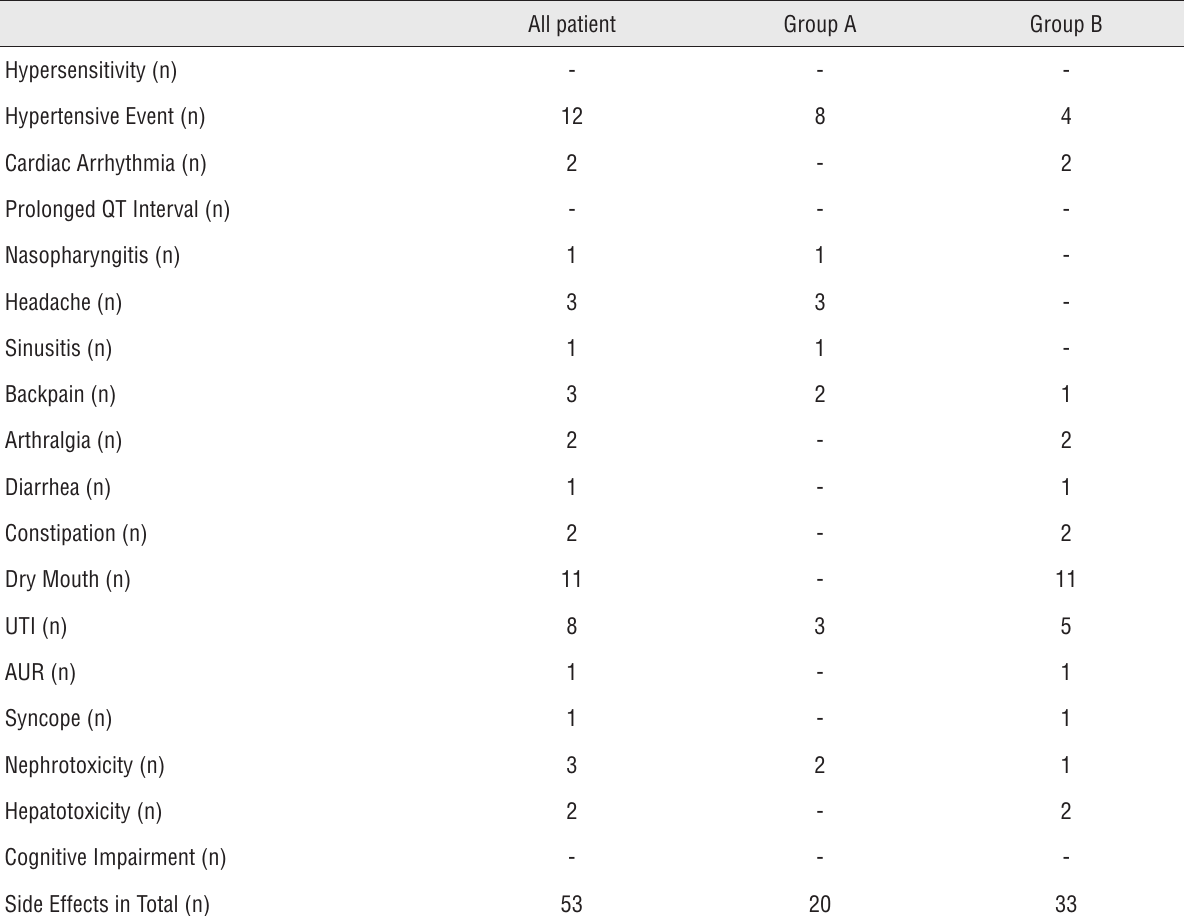
Table 3 - Parameters for Safety